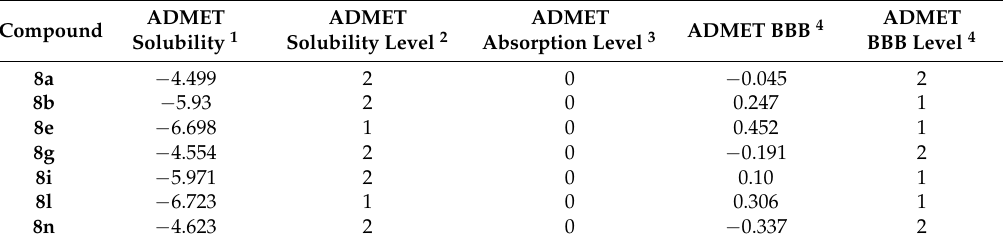
Table 5. ADME studies results for all the synthesized compounds.